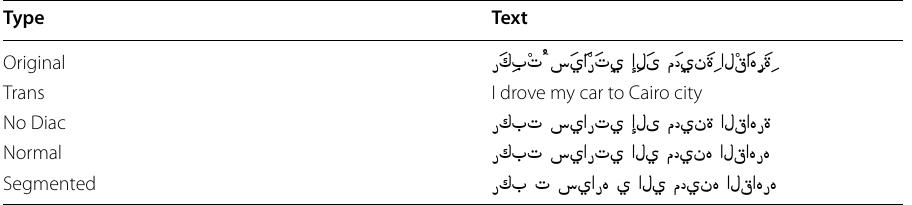
extracted key phrases, two to three words, will correspond to the length of the titles generated by the model we worked